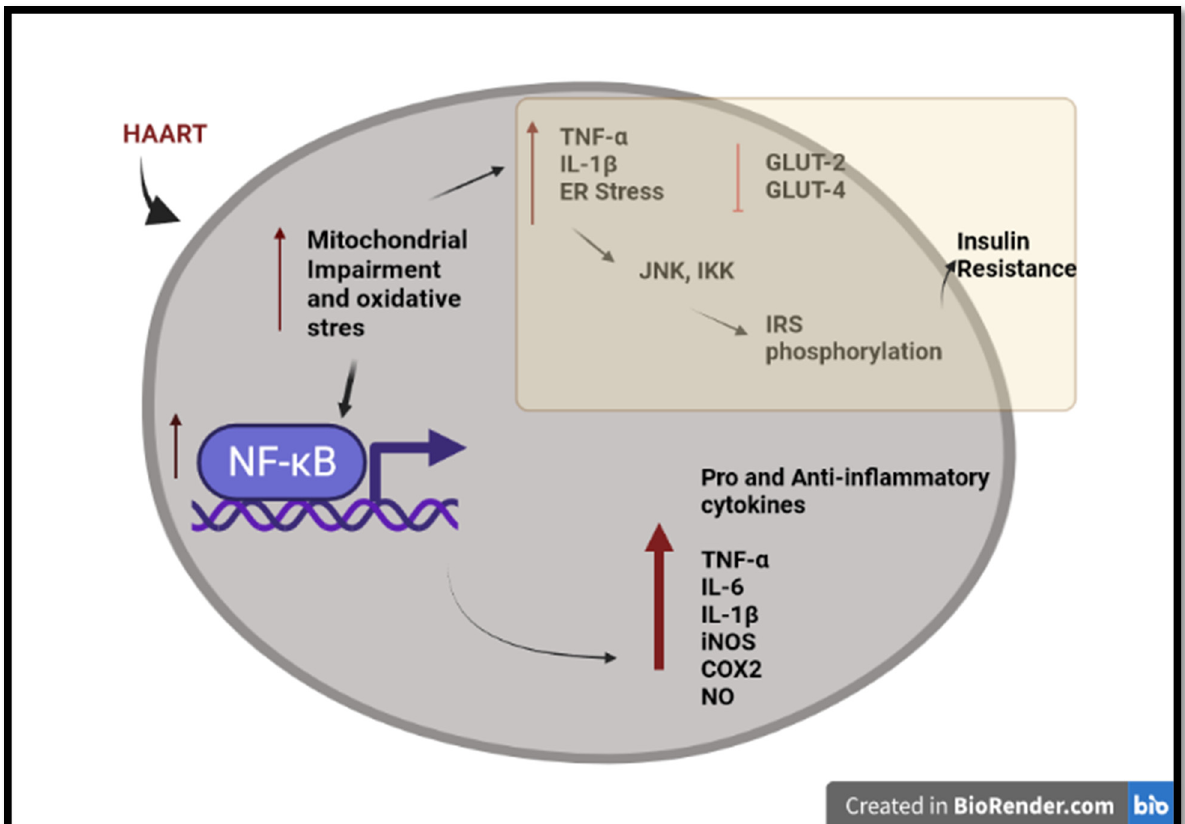
Figure 2. An overview of long-term HAART-induced inflammation and insulin resistance in HIV- infected individuals. HAART induced pro-inflammatory and anti-inflammatory cytokines through mitochondrial impairment, oxidative stress, and activation of NF- κ B. HAART triggers insulin resistance via IRS phosphorylation and the inhibition of the glucose transporter. Created with BioRender.com (access date: 2 June 2022).